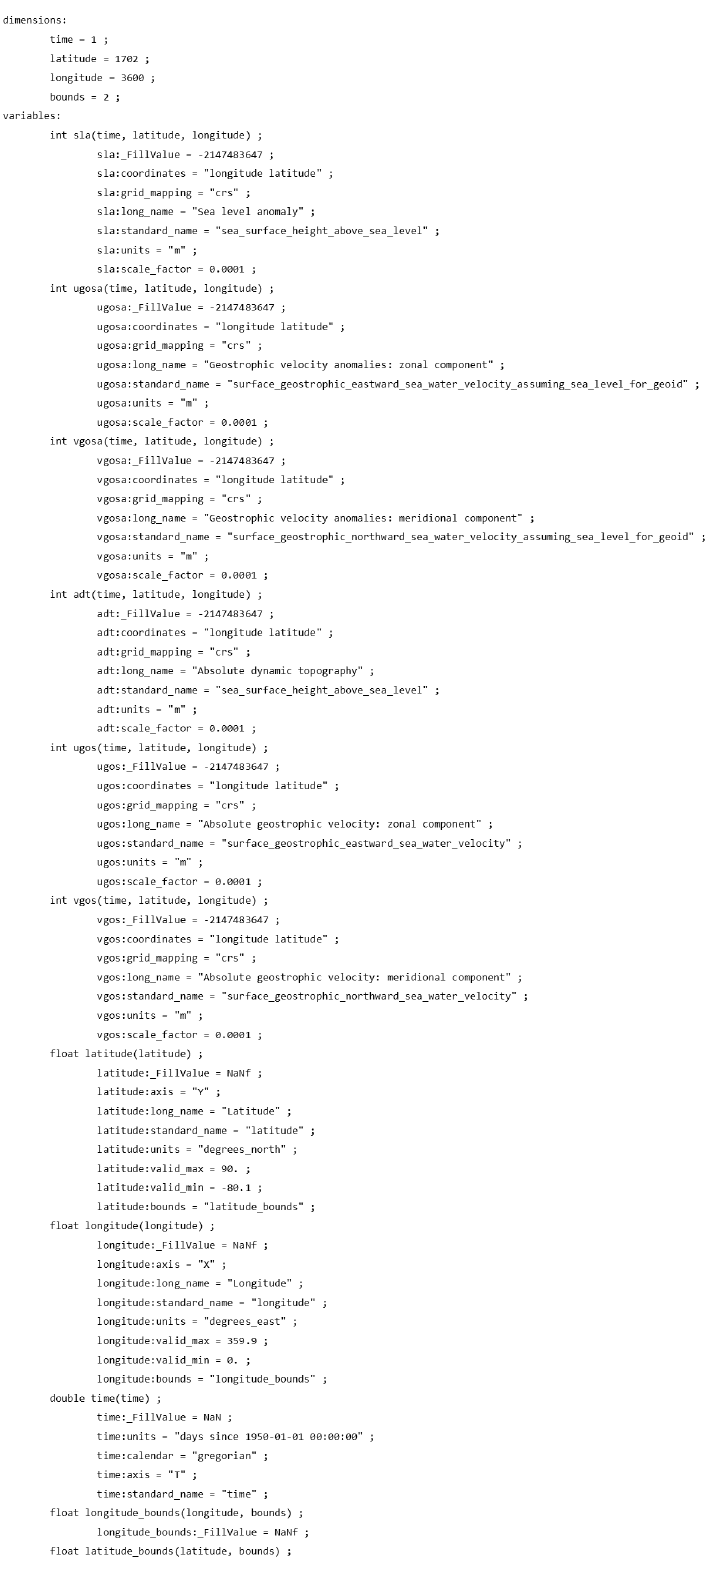
Figure 15. List of variables available in the multiscale and multivariate product.